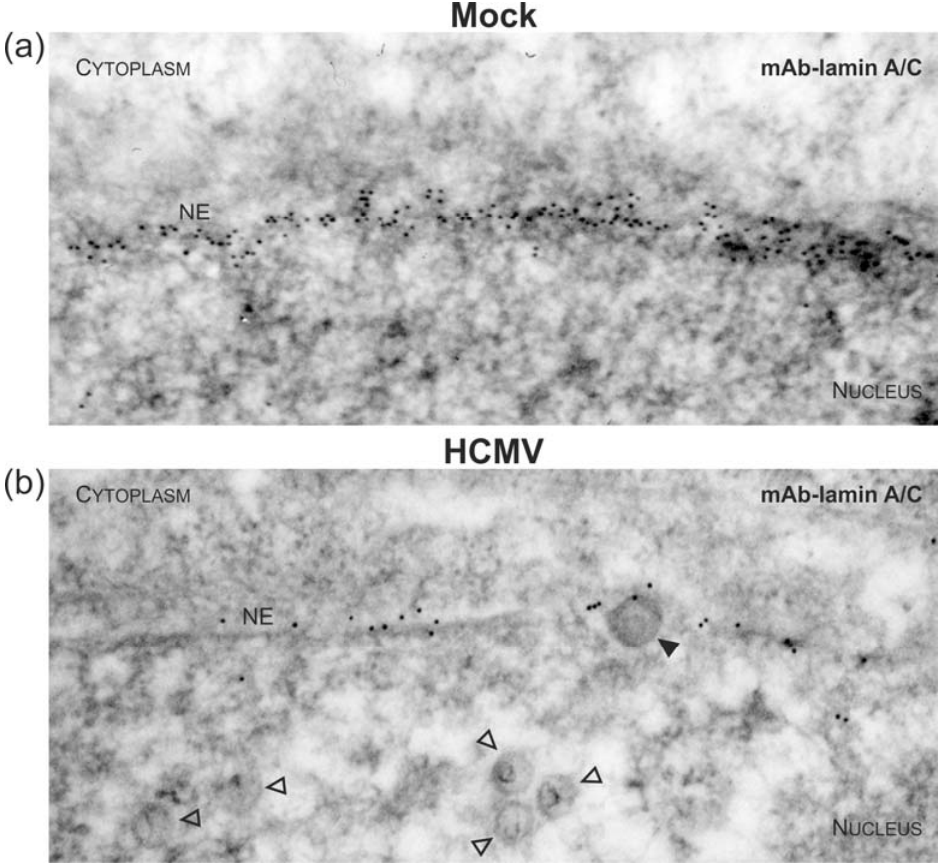
Figure 5. Disassembly of the nuclear lamina during nuclear egress of HCMV capsids visualized by electron microscopy. HFFs were infected with HCMV strain AD169 ( b ) or remained uninfected (mock; ( a )) as indicated. Cells were harvested at 3 dpi and subjected to immunogold staining of A-type lamins (i.e. lamin A/C). Samples were analysed by TEM, 35,970-fold magnification. NE, nuclear envelope; open arrowheads, intranuclear HCMV capsids; filled arrowheads, HCMV capsids budding at nuclear membranes.